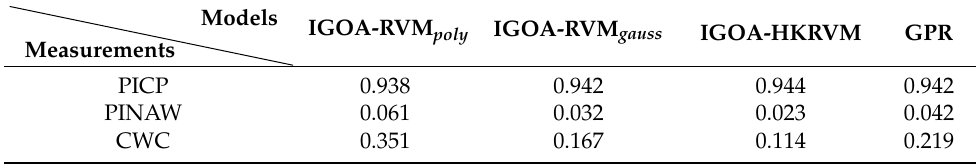
Table 2. The accuracy performance of di ff erent